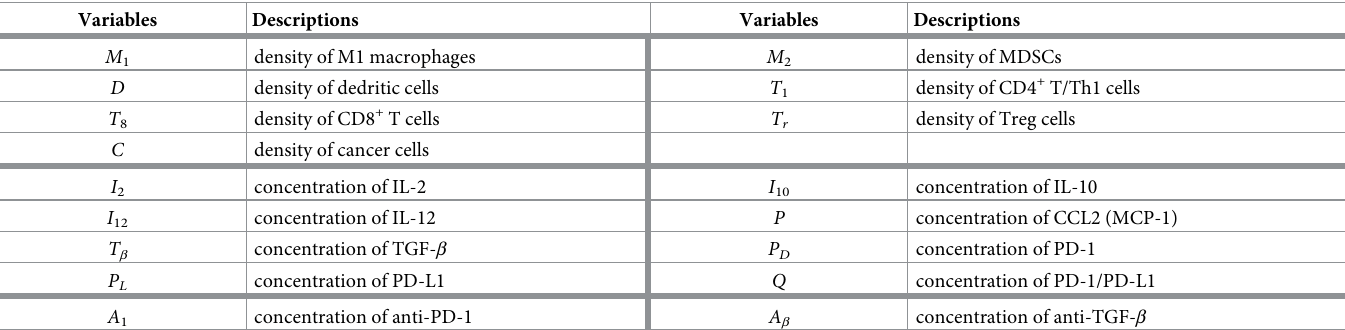
Table 1. Variables of the model. All concentrations are in units of g/cm 3